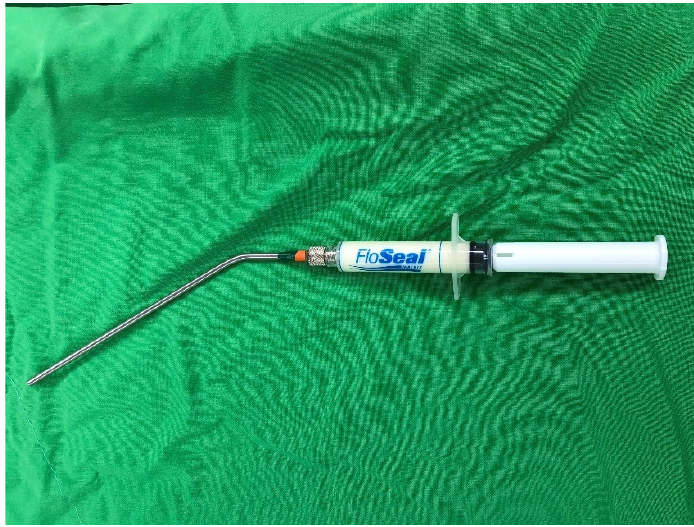
Figure 1. Iron-tube device for injection.